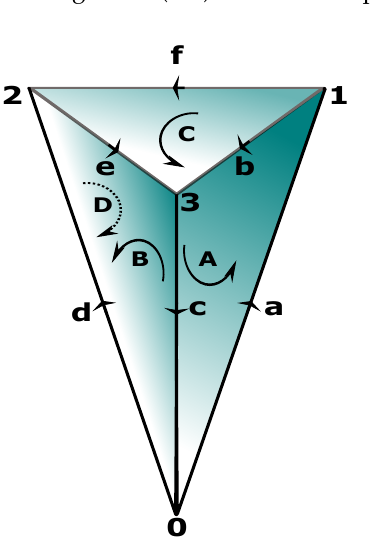
Figure 23 (CC) is homeomorphic to the representation presented below.